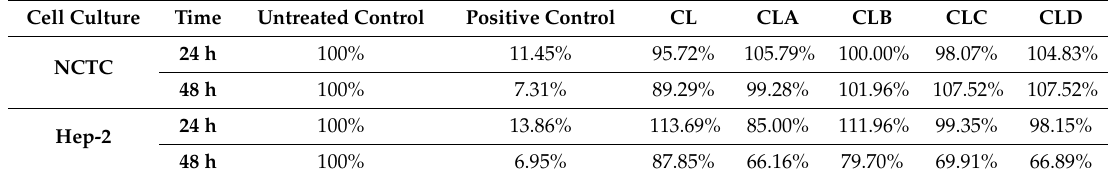
Cell viability values resulted from MTT in vitro assay at 24 and 48 h of treatment with